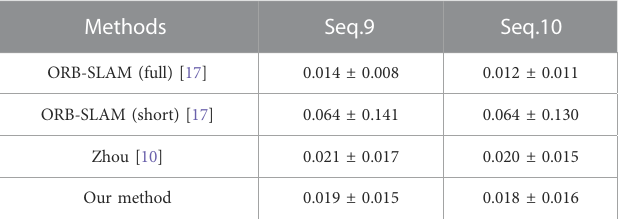
TABLE 2 Absolute trajectory error for validating positional estimation on KITTI test set.